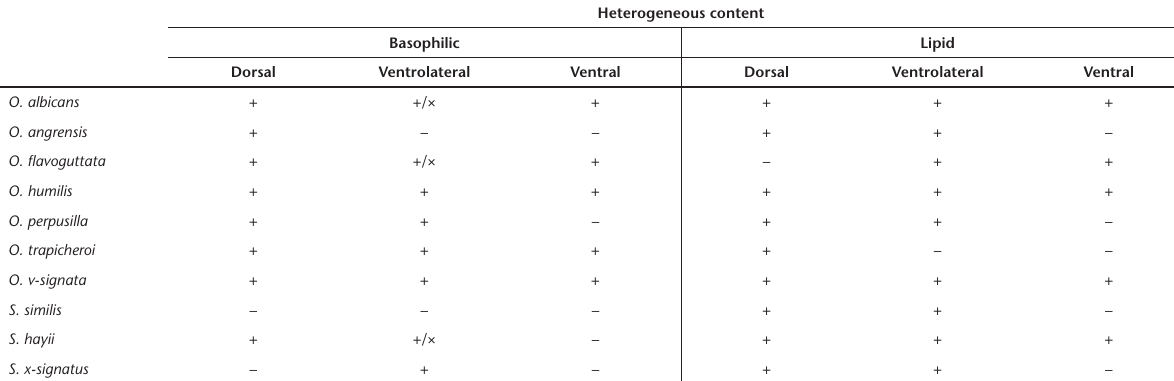
Table 4. Occurence of apocrine glands in the integument of Oloygon spp. and Scinax spp.